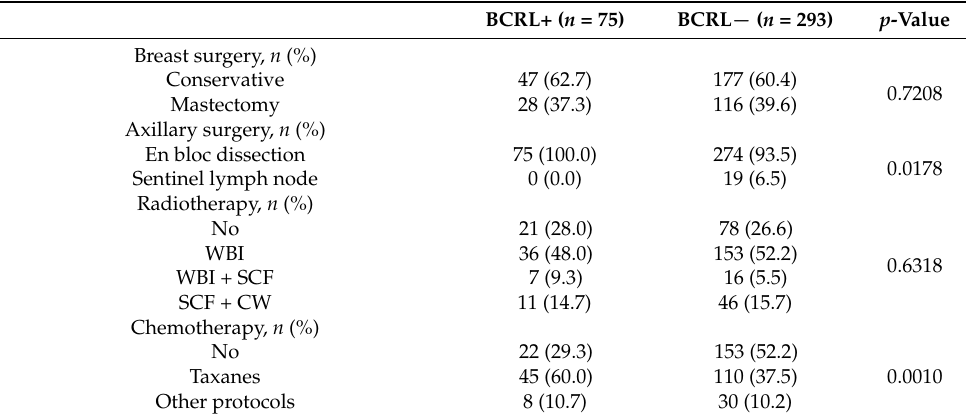
Table 2. Therapeutic protocols of the patients included in the